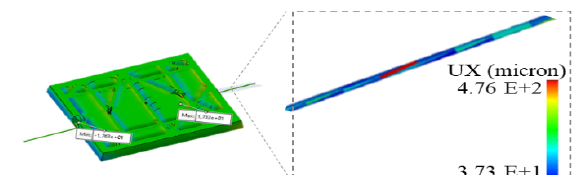
Fig. 2: Example of visual result of simulation. Table 1. Features of six sensors and their simulations results.